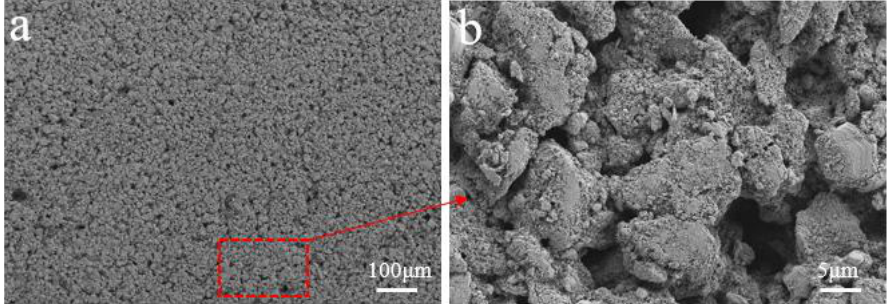
Figure 1. Surface microstructure of a pristine LiMn 2 O 4 composite electrode ( a ) and ( b ) at different